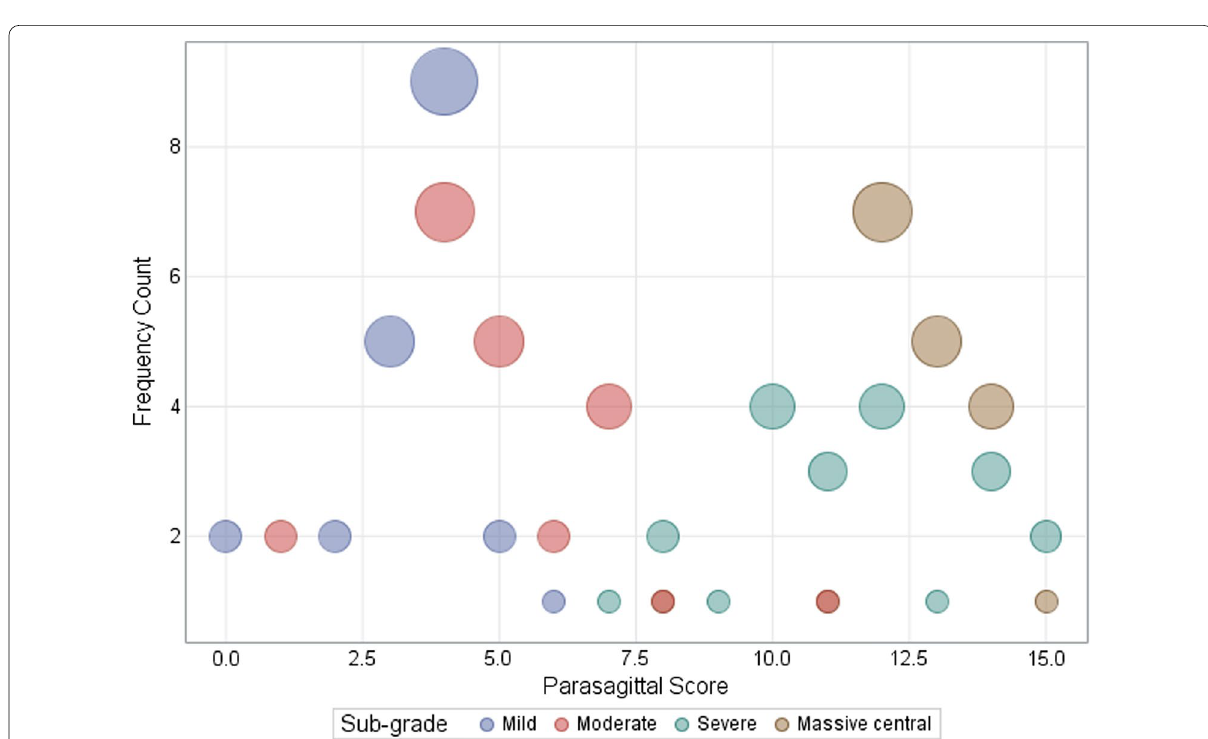
Fig. 6 Grid‑bubble chart of the frequency of parasagittal scores for subtypes of central